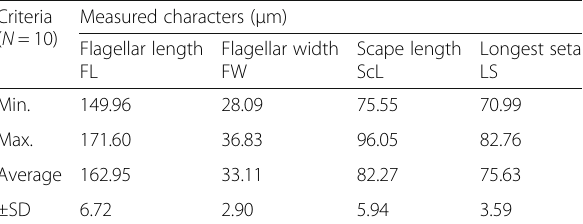
Table 1 Measured characters ( μ m) of Trichogramma strain TNV male antenna